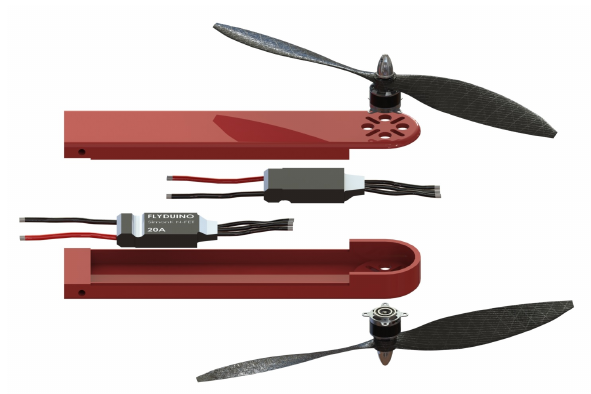
Figure 10: Electronic and avionic elements in the arm for the am- phibious